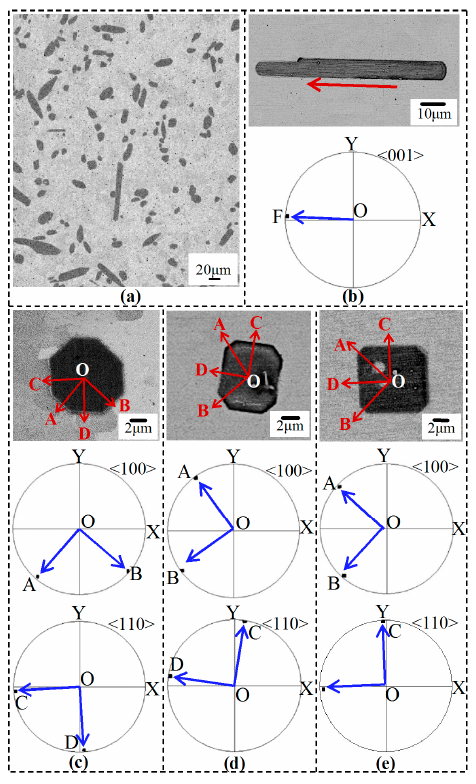
Figure 1. BSE image of ( a ) the solidified Sn ‐ Mn alloy; Typical magnified images of the MnSn 2 crystals with ( b ) bar ‐ like, ( c ) approximately regular octagonal, ( d ) non ‐ regular octagonal and ( e ) square shapes, respectively. The <001> pole figure in ( b ) indicates the growth direction of the bar ‐ like crystal (the projection line OF is parallel to the interface trace of the crystal); the <100> and <110> pole figures in ( c – e ) illustrate the side facets binding the octagonal and square bases (the projection lines OA, OB, OC and OD are parallel to the normals OA, OB, OC and OD of the side surface traces of the crystals,